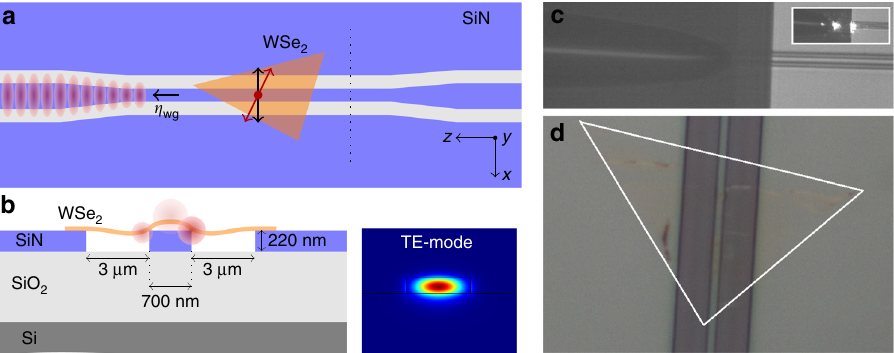
Fig. 1 Integrated WSe 2 quantum emitters. a Top view of the device: a WSe 2 fl ake is integrated on a 220 nm thick single mode SiN waveguide, separated by 2 air trenches from the bulk SiN. The waveguide ends are tapered to allow easier coupling with a lensed fi ber. The orientation of the dipole moment of the WSe 2 emitters (red arrow) is random with respect to the quasi-TE polarization (approximately aligned along x − direction) of the fundamental waveguide mode (black arrow). A fraction η wg of the total emission couples into the left-propagating waveguide mode (represented by red shaded areas). b Cross- section of the sample. The width of the air trenches and waveguide is 3 μ m and 700 nm respectively. The generated PL of emitters near the waveguide couples both to free-space and to the waveguide (red shaded circles). A cross-sectional mode pro fi le (at λ = 750 nm) of the waveguide, taken along the dotted black line in the top fi gure, is shown as well. c Impression of the fi ber-coupled chip (inset shows light coupling from the fi ber to the chip). The tapered lensed fi ber is a standard SM630 fi ber from Thorlabs with a focal spot size of 2 μ m and an 8 μ m working distance. d Microscope image of SiN chip with WSe 2 transferred on waveguide region. The fl ake is highlighted by the white triangle